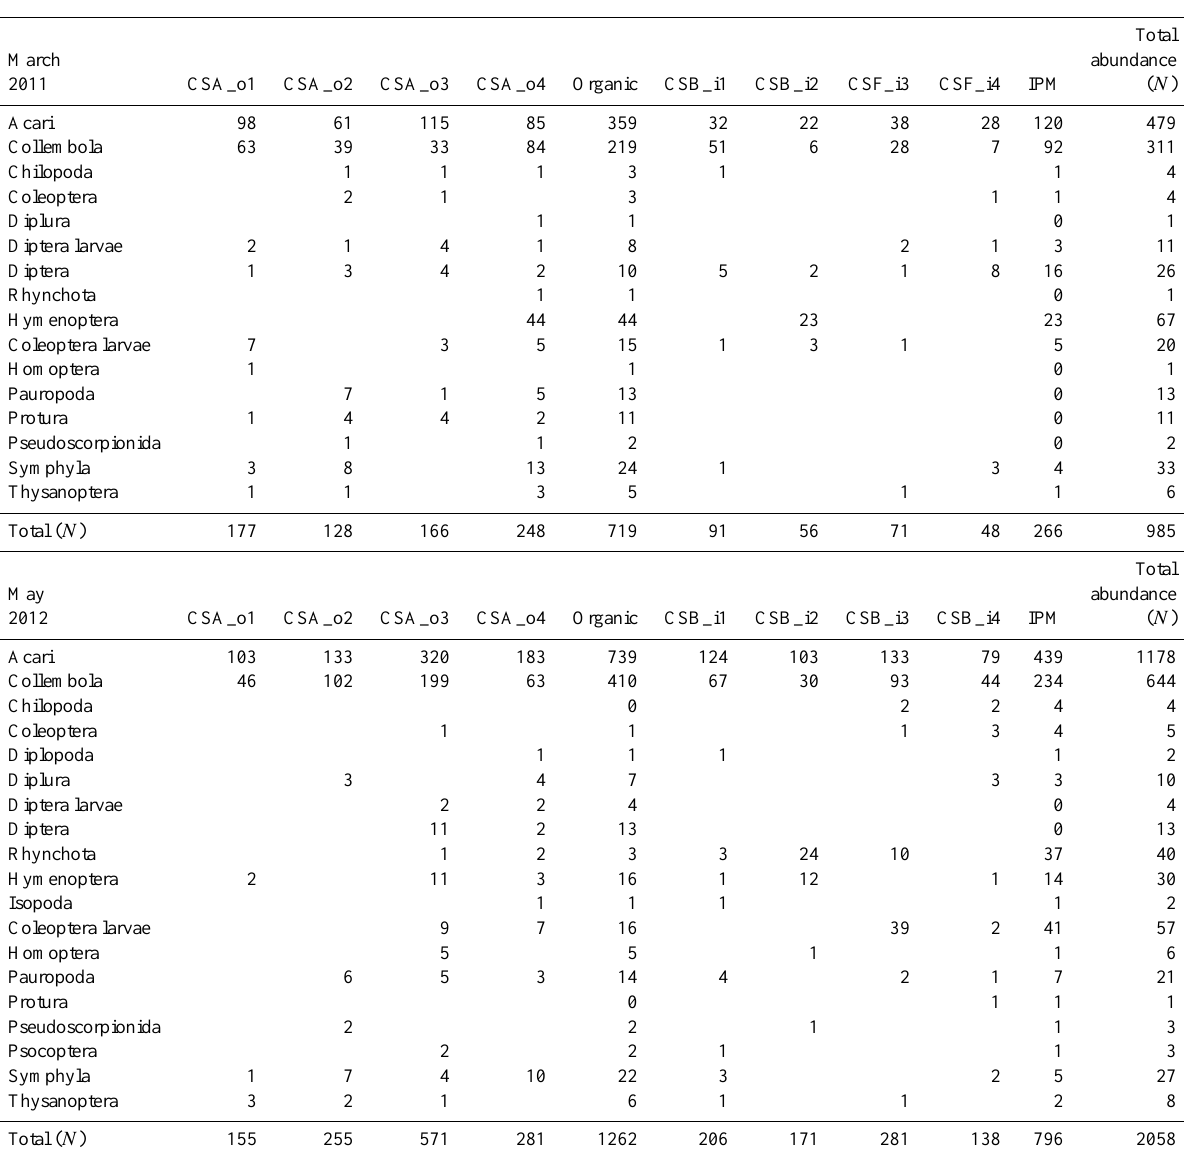
Table 3. Community structure of the soil microarthropods ( N ) (biological forms as morphotypes adapted to soil) (Parisi et al., 2005) at different sampling times and in the eight vineyard